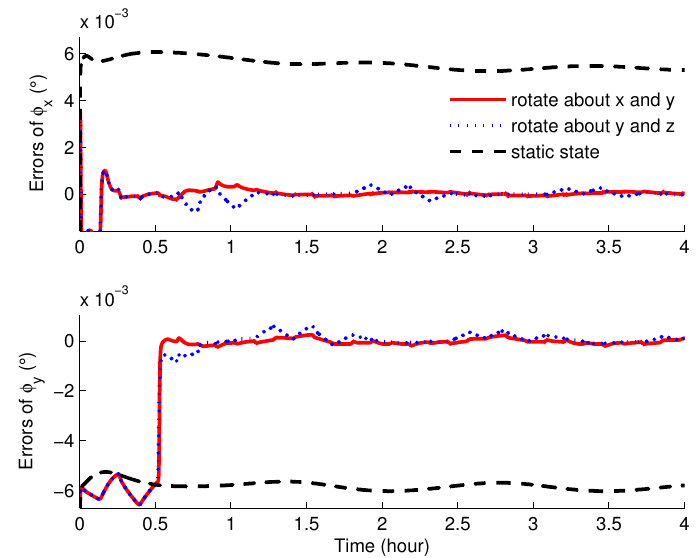
Figure 5. The estimated errors of the horizontal misalignment angles of rotation and static simulations.